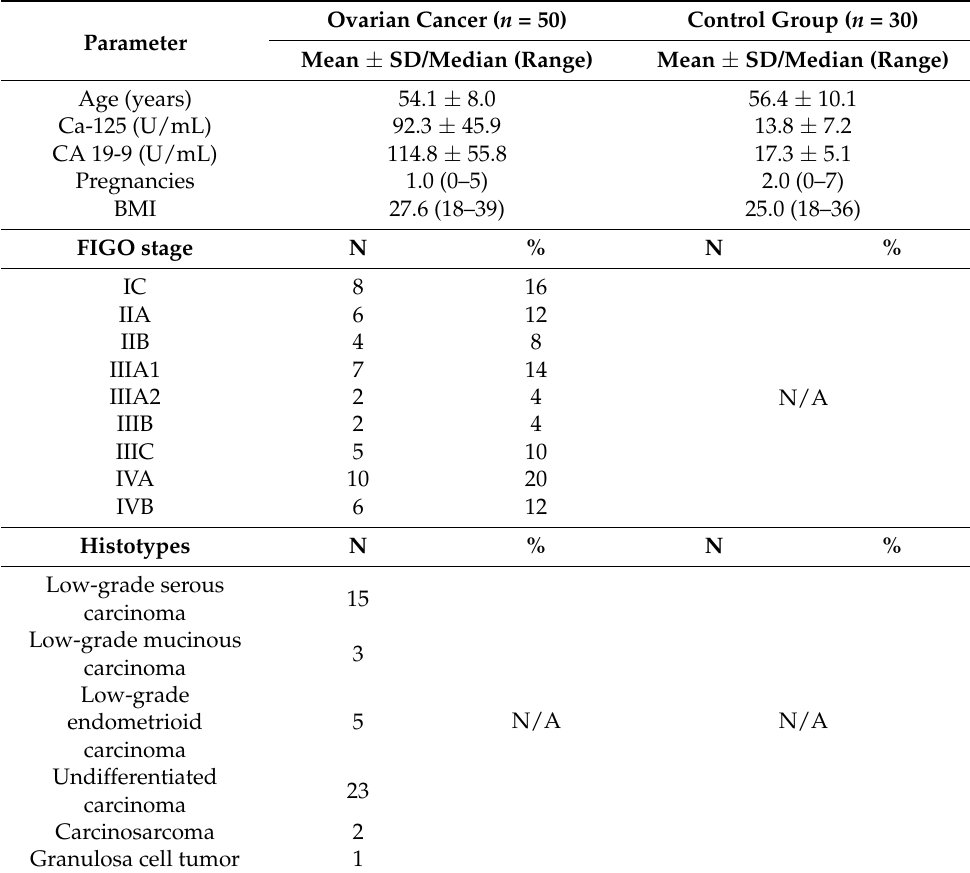
Table 1. Basic characteristics of the study and the control groups.